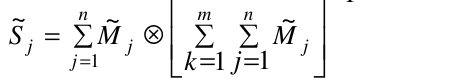
Figure 4: The intersection between